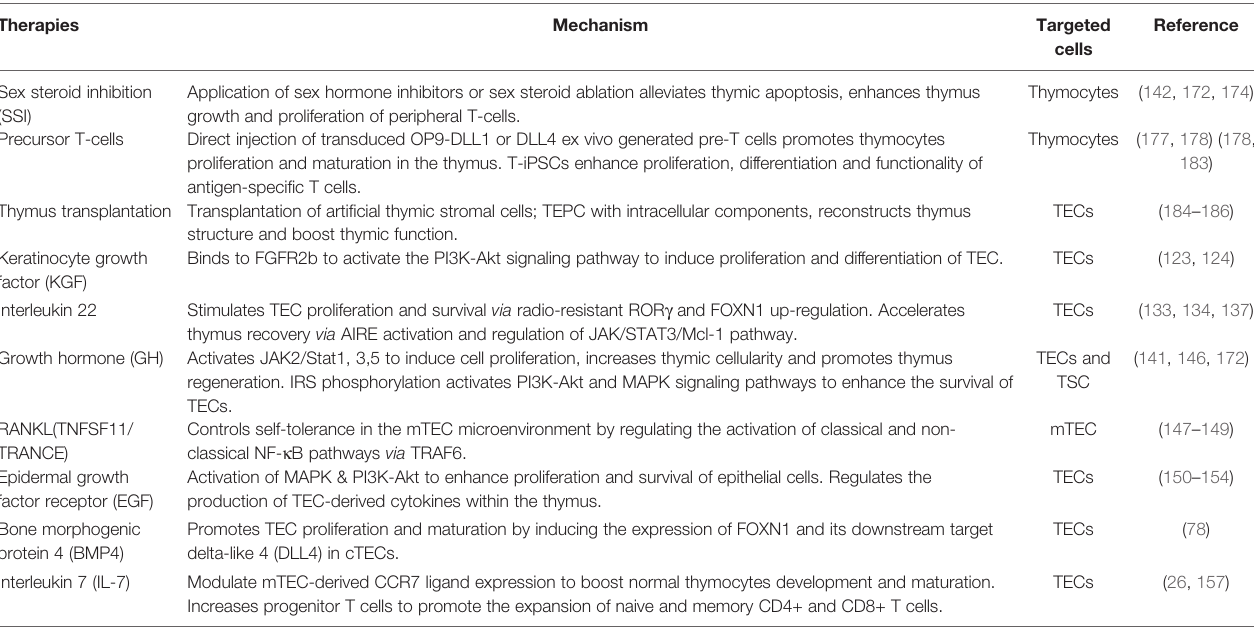
TABLE 1 | Summary of thymus regeneration therapeutic strategies.